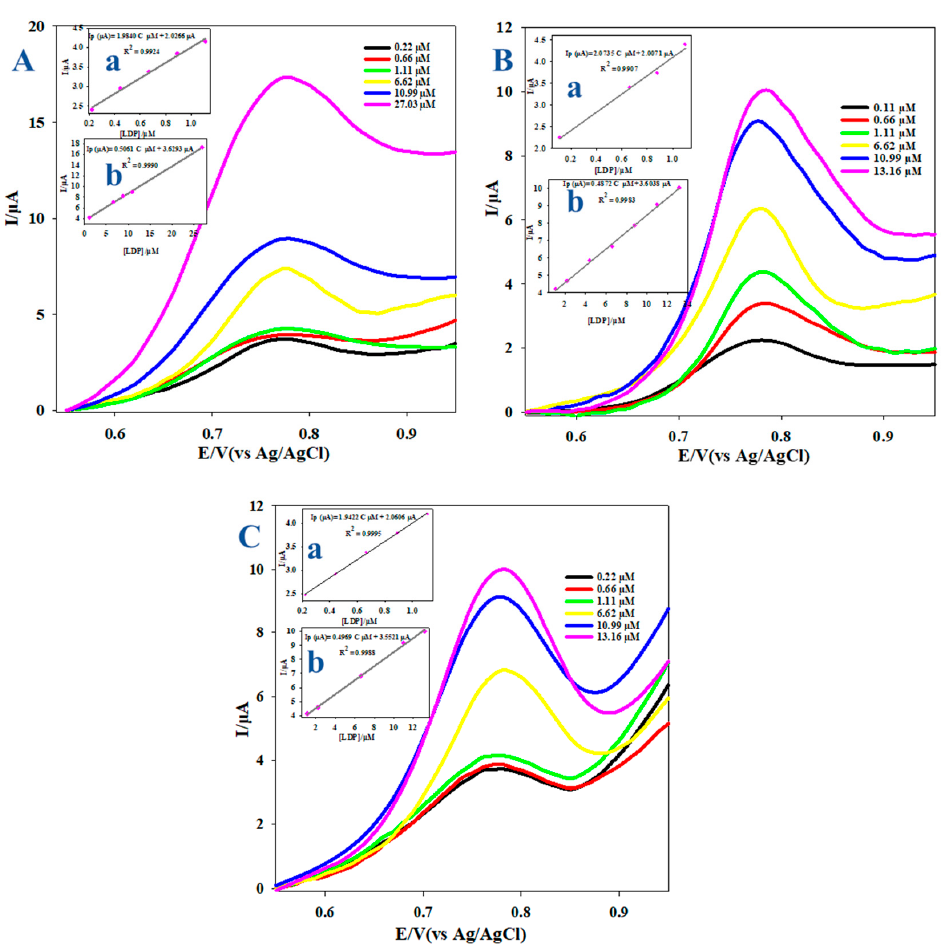
Figure 8. Square wave voltammogram for various concentrations of MTX in ( A ) spiked plasma (0.22–27.03 μ M), ( B ) MTX Tablet (0.11–13.16 μ M), and ( C ) spiked urine (0.22–13.16) samples in pH (0.22–27.03 µ M), ( B ) MTX Tablet (0.11–13.16 µ M), and ( C ) spiked urine (0.22–13.16) samples in pH 7.0 of BR buffer at the scan rate of 100 mV s − 1 using g-CN/CPE. Inset ( a ) shows the calibration curve